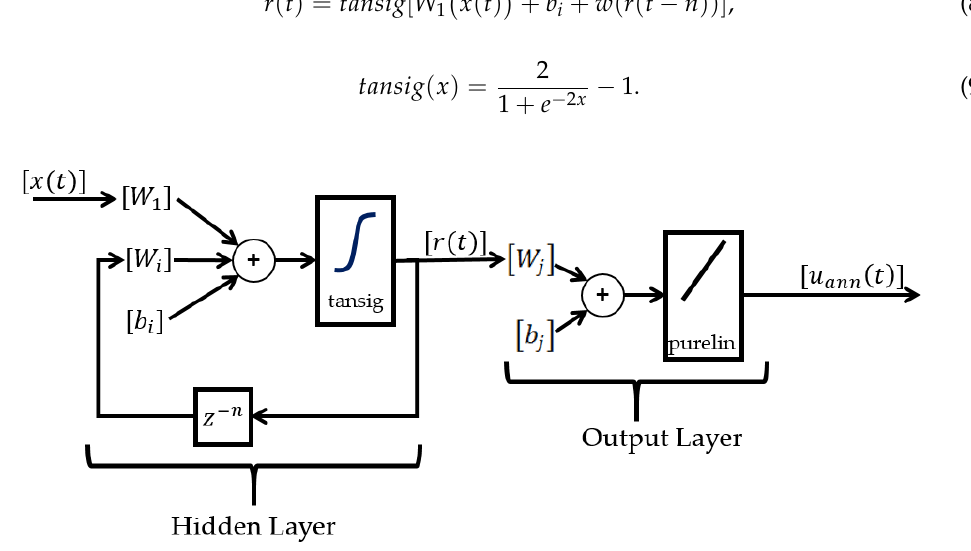
Figure 5. Recurrent artificial neural network (ANN)